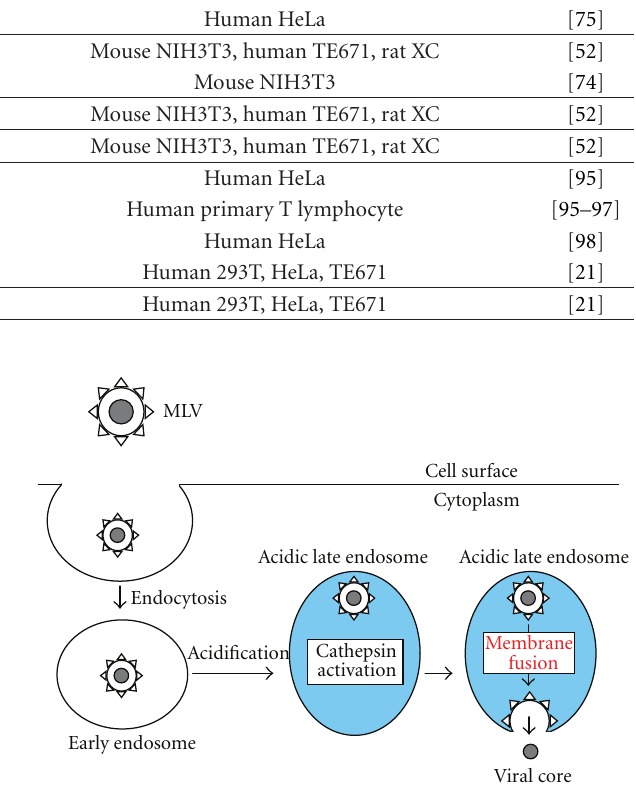
Figure 2: Entry pathway of ecotropic MLV in almost all susceptible cells. Blue area indicates acidic